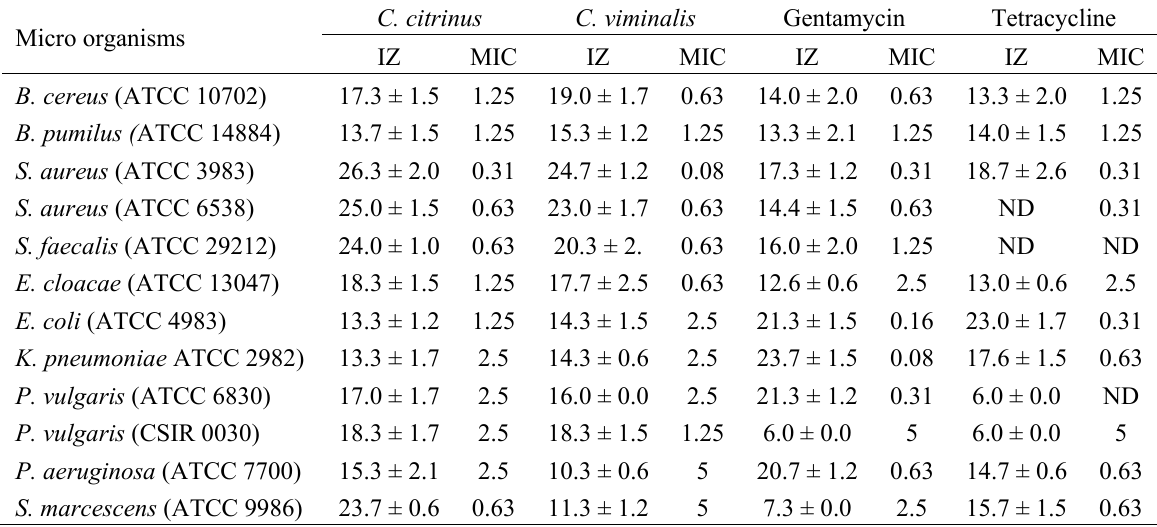
Table 2. Antibacterial activity of the essential oils of C. citrinus and C. Viminalis. Micro